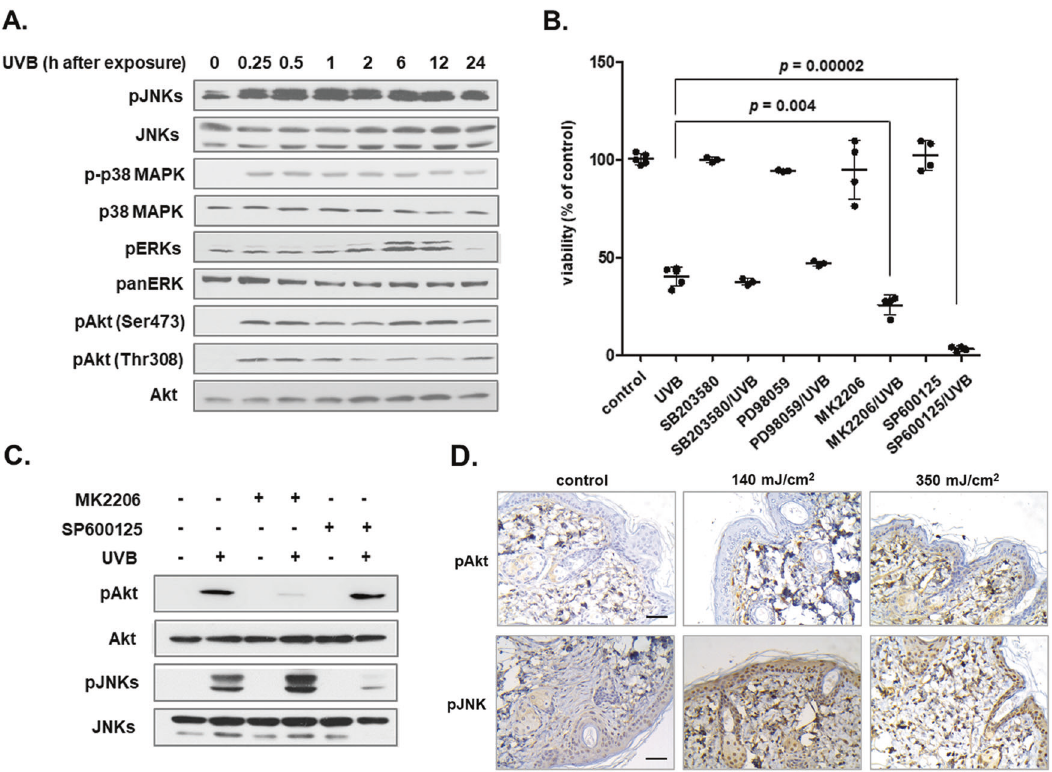
Fig. 2 Akt and JNKs are the key players in the cellular response of human dermal fi broblasts towards UVB radiation. A Cells were irradiated with an irradiation dose of 700 mJ/cm 2 and further incubated at 37 o C for the designated time periods before total protein extraction, SDS-PAGE, protein transfer and western blot analysis with antibodies against the phosphorylated forms of JNKs, p38 MAPK, ERKs, and Akt. Representative blots of three independent experiments are shown here. Western blot analysis for the non-phosphorylated forms of the kinases was performed to verify equal loading. B Cells were pre-treated with the speci fi c MAPKs and Akt inhibitors [SB203580 for p38 MAPK (10 μΜ ); PD98059 for ERKs (25 μΜ ), SP600125 for JNKs (5 μΜ ), and MK2206 for Akt (1 μΜ )] for 1 h before UVB treatment with 700 mJ/ cm 2 . Cells were further incubated at 37 o C for 72 h before trypsinization, staining with Neutral Red and cell counting ( N = 4). p for statistically signi fi cant differences in comparison to the respective sample without any inhibitor (Student ’ s t test) is presented in the graph. C Cell cultures were pre-incubated with 1 μΜ of the Akt inhibitor MK2206 and 5 μΜ of the JNKs inhibitor SP600125 for 1 h before exposure to 700 mJ/cm 2 of UVB radiation, total protein extraction and western blot analysis for phospho-Akt at Ser473 and phospho-JNKs. The non-phosphorylated forms of the kinases served as loading controls. Western blot analyses were repeated three times and a representative experiment is presented here. D SKH-1 hairless mice were exposed to 140 and 350 mJ/cm 2 of UVB radiation before sacri fi ce 1 h post-irradiation and removal of the dorsal skin. Non-irradiated (control) vs . irradiated tissue sections were stained using antibodies against the phosphorylated forms of Akt at Ser473 and of JNKs. Pictures of pAkt and pJNKs in situ expression shown here are representative of three independent experiments. Scale bar = 50 μ